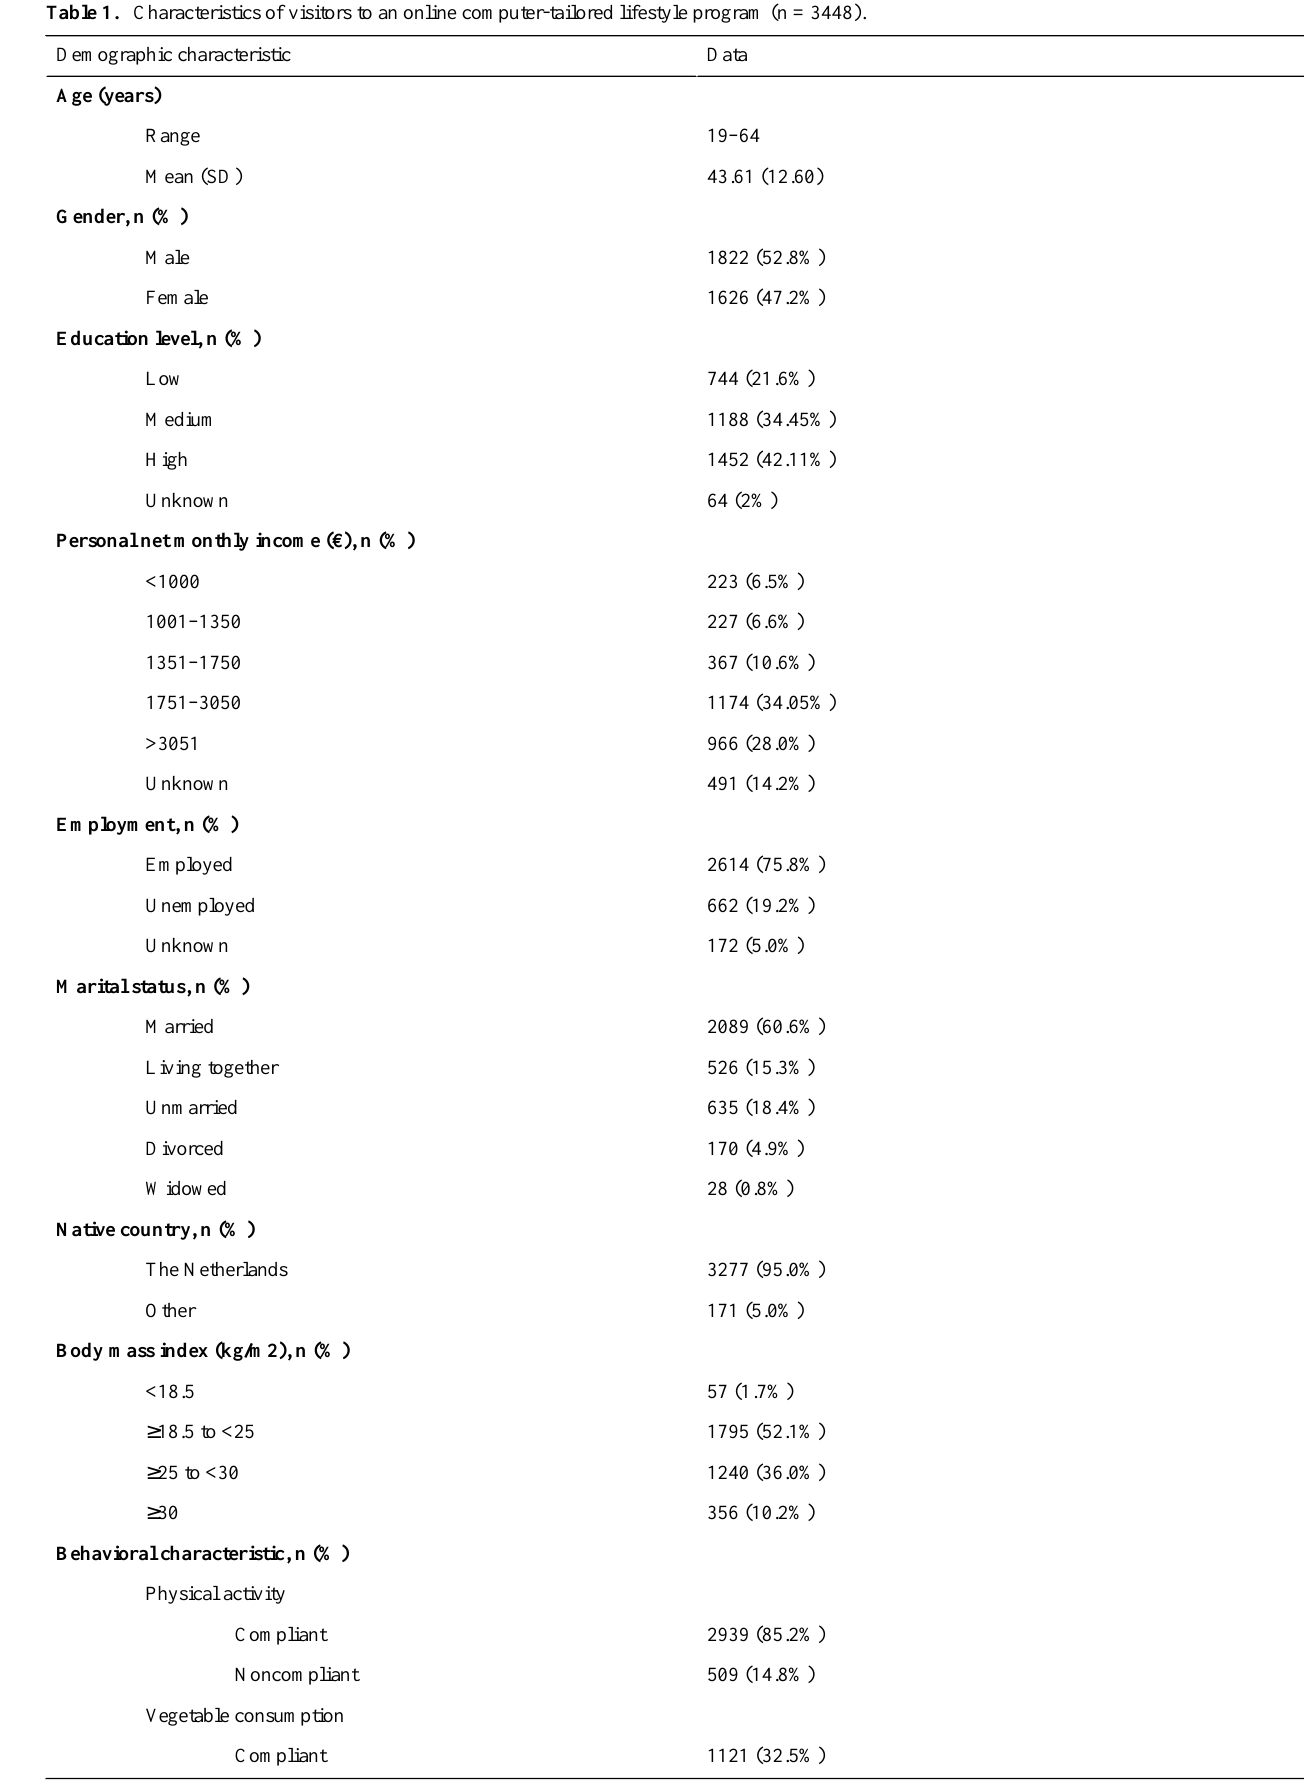
Table 1. Characteristics of visitors to an online computer-tailored lifestyle program (n =